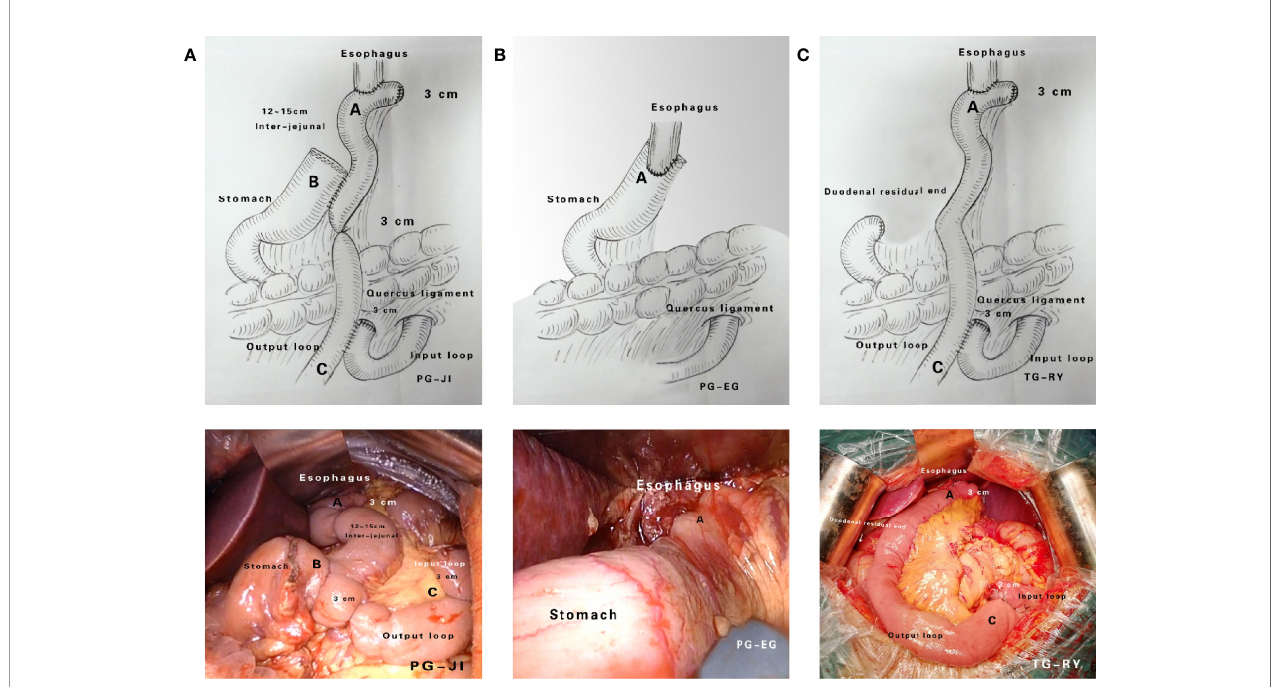
FIGURE 2 | Surgical approaches. (A) Proximal gastrectomy + jejunal interposition (PG+JI). (B) Proximal gastrectomy + esophagogastrostomy (PG+EG). (C) Total gastrectomy + Roux-en-Y esophagojejunostomy